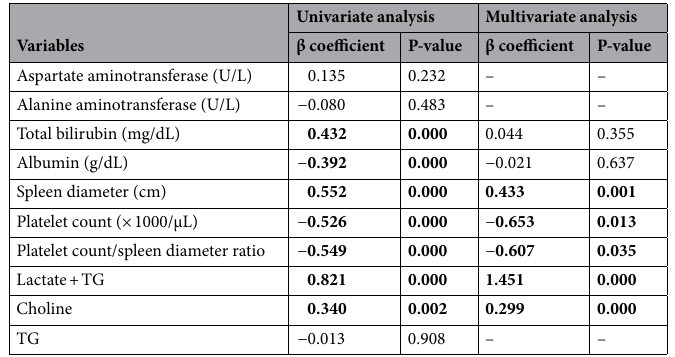
Table 2. Regression analysis for verifying the association of various variables with the presence of VNT. Bolded values are significant at P < 0.05. VNT, varices needing treatment; TG,